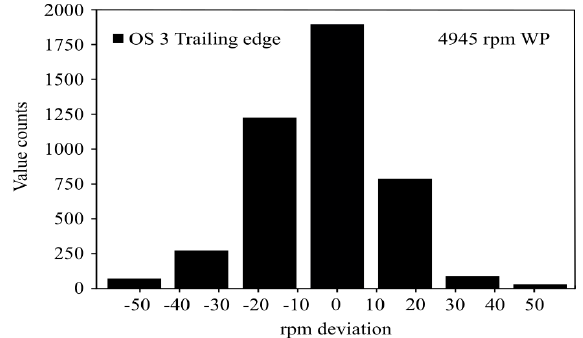
Figure 7. Histogram representing the deviation of the calculated instantaneous speed with respect to the nominal speed (4945 rpm) for the OS 3 sensor using the datum trailing edge. Data obtained from 52 consecutive shaft turns.